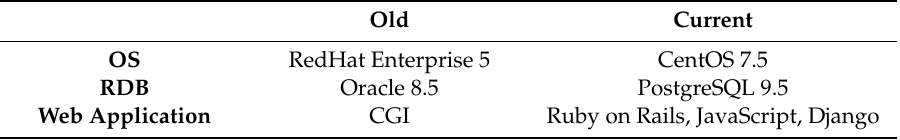
Table 2. The major software components used for the old and current systems.